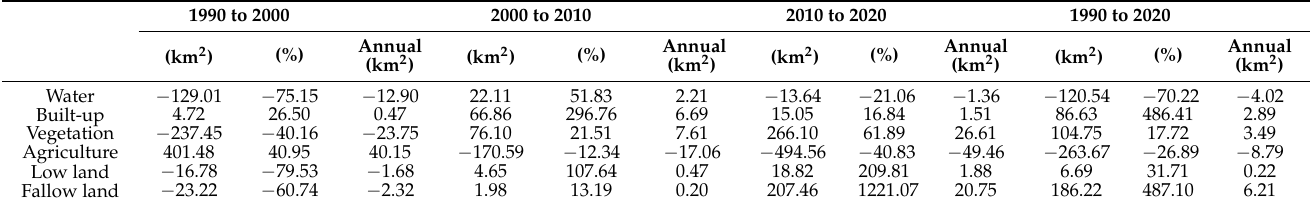
Figure 5. Relative change (km 2 ). Table 5. Land-use/land-cover change